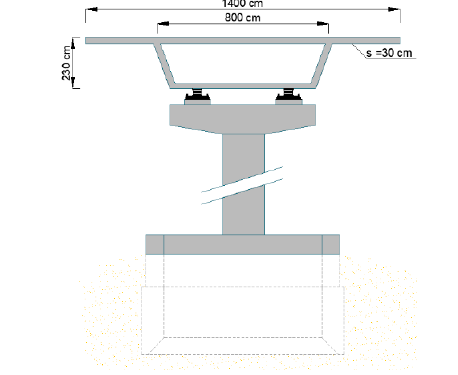
Figure 6. Layout of the bridges: regular bridge (RB) and irregular bridge (IB).